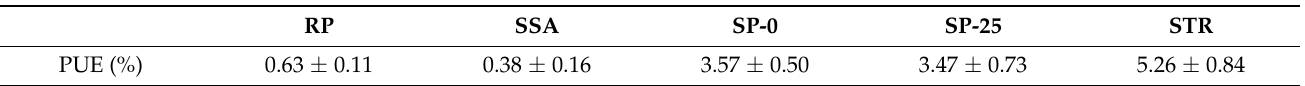
Table 7. P use efficiency (PUE) means ± standard deviation of different fertilizer treatments. For fertilizer abbreviations see Table